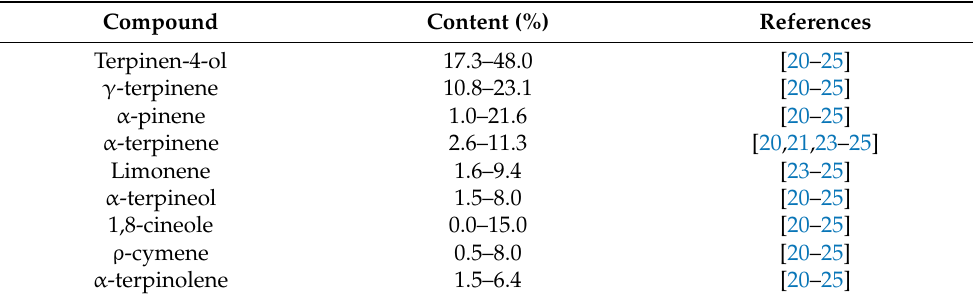
Table 1. The main compounds of M. alternifolia leave essential